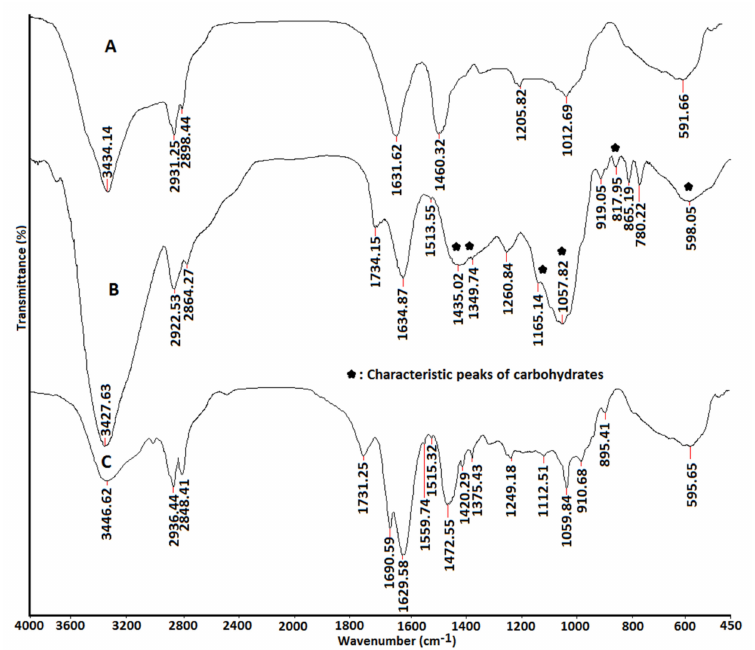
Figure 2. The FTIR spectra of ( A ) PDDA, ( B ) PDDA/honey (40/60% w / w ), and ( C ) crosslinked PDDA/honey (40/60% w / w ) nanofiber